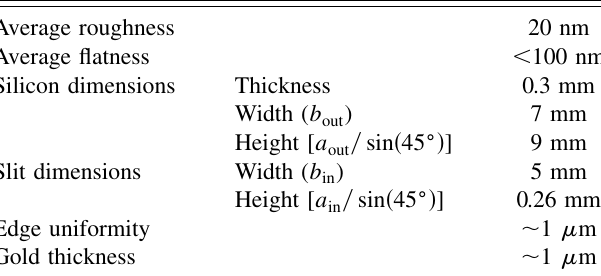
TABLE II. Target parameters.